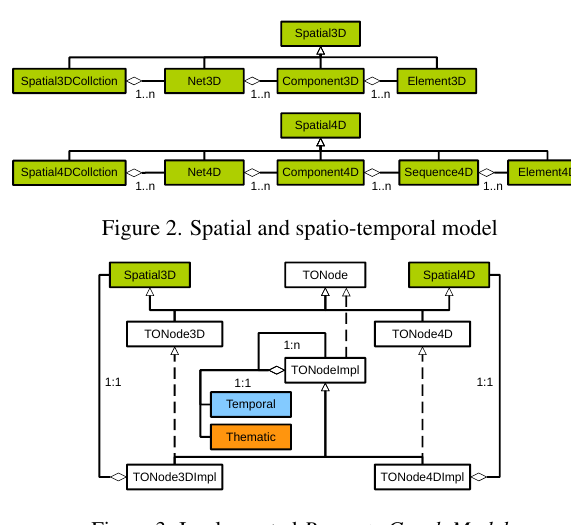
Figure 3. Implemented Property Graph